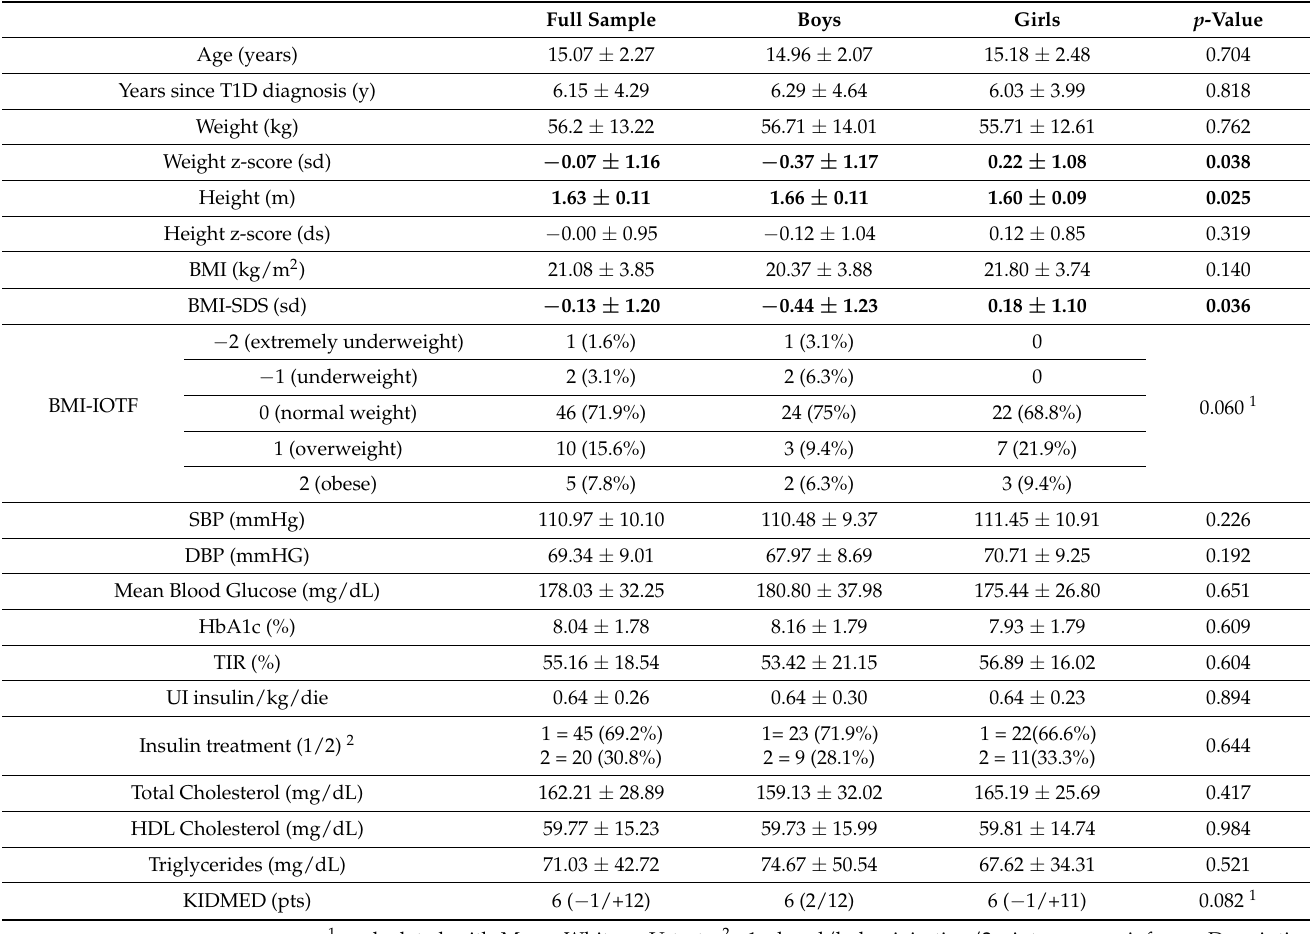
Table 1. Descriptive characteristics of